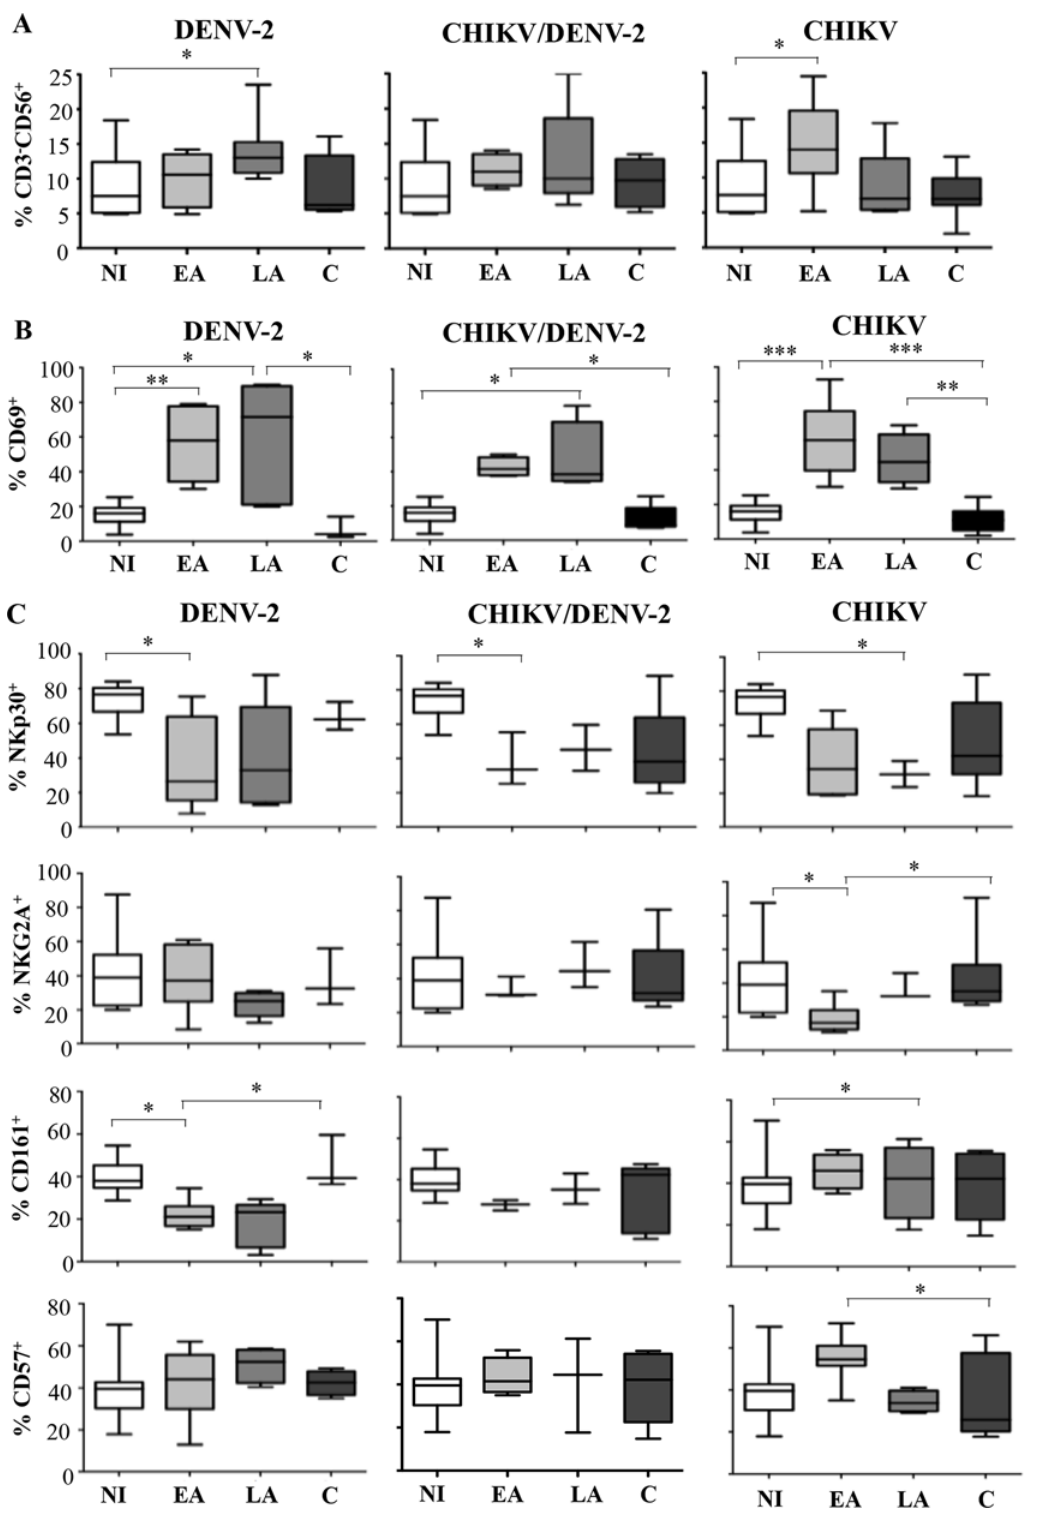
Fig 1. Frequencies and characteristics of NK cells in patients infected with DENV-2, CHIKV, co-infected with CHIKV and DENV-2 (CHIKV/DENV-2), and non-infected and healthy Gabonese controls (NI). Patients were sampled in early acute (EA; day (D)0-D3), late acute (LA; D12-D15) and convalescent (C; D > 30) stages post-onset of symptoms. Frequencies of CD3 - CD56 + NK cells within the CD45 + lymphocyte gate (A), frequencies of early activation marker CD69 (B) and NKp30, NKG2A, CD161, CD57 cell-surface receptors (C) on CD3 - CD56 + NK cells are represented. * p < 0.05, ** p < 0.001. doi:10.1371/journal.pntd.0004499.g001 PLOS Neglected Tropical Diseases | DOI:10.1371/journal.pntd.0004499 March 3,